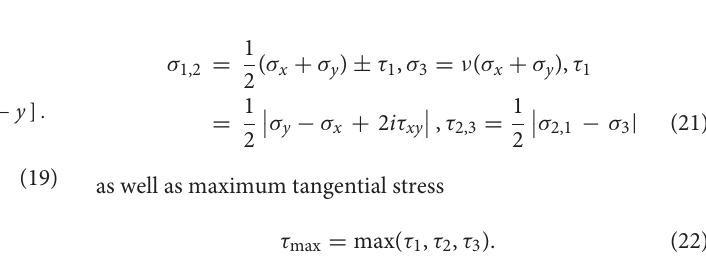
Figures 3 , 4 present the level lines of maximum tangential stress τ max , calculated for Poisson’s ratio ν 0.3. The solid lines = correspond to τ max , and the dashed ones point to τ 1 , if τ 1 < τ max τ 2 . Figure 3A refers to a smooth contact ( Q / P 0), = = Figure 3B ( µ 0 0.25, Q / P 0.15), and Figure 4A ( µ 0 0.5, = = = Q / P 0.3) refer to a contact with slip and adhesion, and = Figure 3C ( µ 0 Q / P 0.25) and Figure 4B ( µ 0 Q / P = = = = 0.5) refer to a sliding contact. Distribution of stress τ max for a contact with slip and adhesion is transitional between the same distribution for the smooth and sliding contacts. In this case, the largest values of stress τ max increase, while the force ratio Q / P moves from 0 to µ 0 . If a friction coefficient µ 0.25, then = the value max τ max max τ 1 is reached at point x x 0 , = = ± y y 0 inside each of contacting bodies. This point is shifting = ± in a direction of shear loading and closer to the surface of the body in comparison with a smooth contact ( Table 1 ). If a friction coefficient µ 0 0.5, then with increase in Q / P , this point comes = first to the surface of the body; and second, while moving to a sliding contact, the value τ max becomes the largest at all points of contact area (max τ max max τ 1 0.5 2 P , 1 < x / a < π a = = − 1, Figure 4B ). In addition, under sliding contact conditions for µ 0 0.25 (as shown in Figure 3C ), the largest value τ max = = 0.331 2 P , slightly bigger than the value max τ 1 0.330 2 P inside π a π a = a half-plane, is reached within the slip zone at points x / a